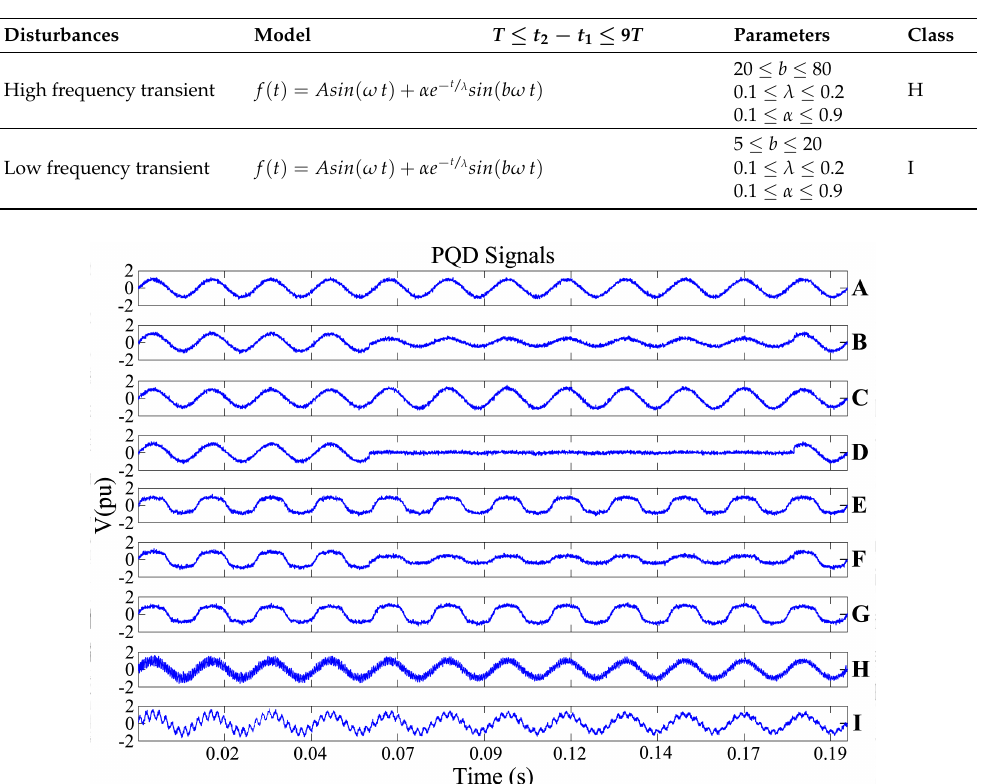
Figure 4. Signals with power quality disturbance (PQD) obtained through the mathematical definitions in Table